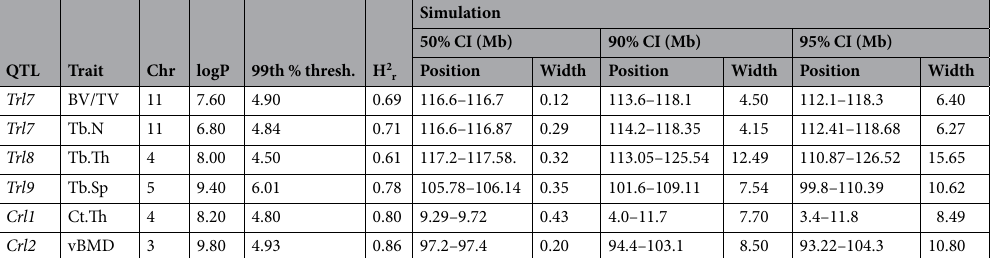
TV (Table S1A) fits the leveled C:C and T:T groups (P value = 0.8 using Welch’s two sample t-test). See Table S4 for information about how the lines spread across the alleles.